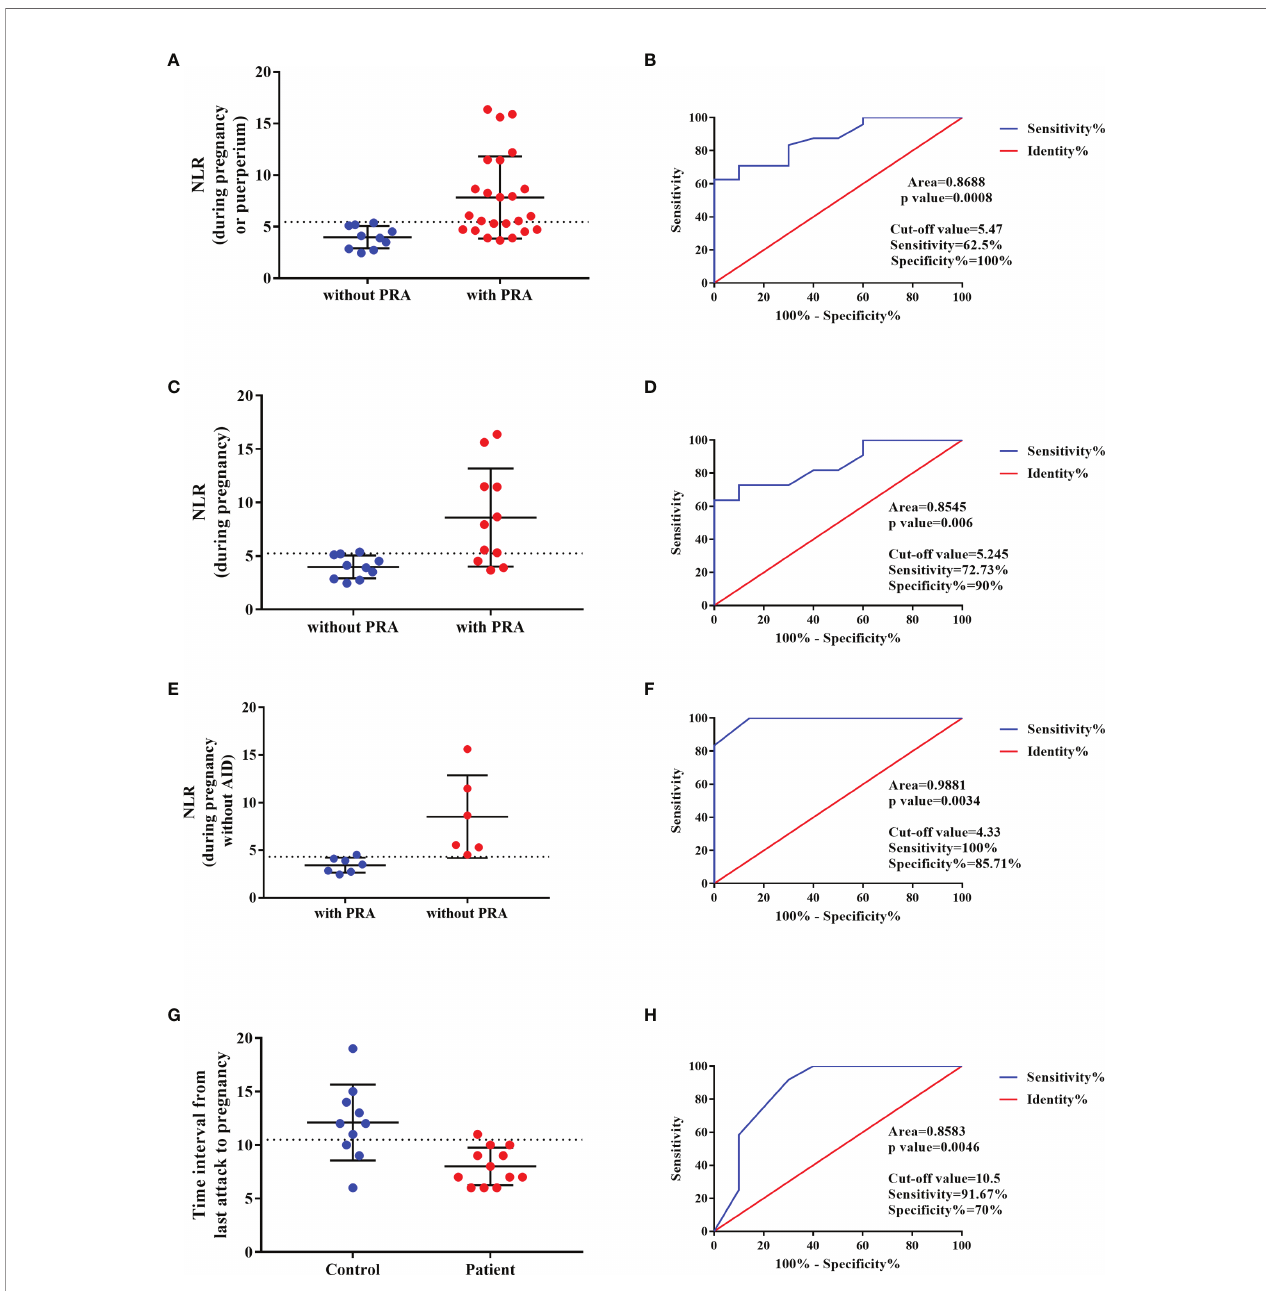
FIGURE 4 | Predictor of the NMOSD relapse during pregnancy. (A, C, E) NLR value in NMOSD with pregnancy-related attacks (PRAs) compared to those with NMOSD who were PRA-free, and the ROC curve for this is presented in (B, D, F) , respectively. (G) The time interval between last relapse and conception in NMOSD patients with PRA compared with NMOSD patients without PRA and the ROC curve was built in (H)